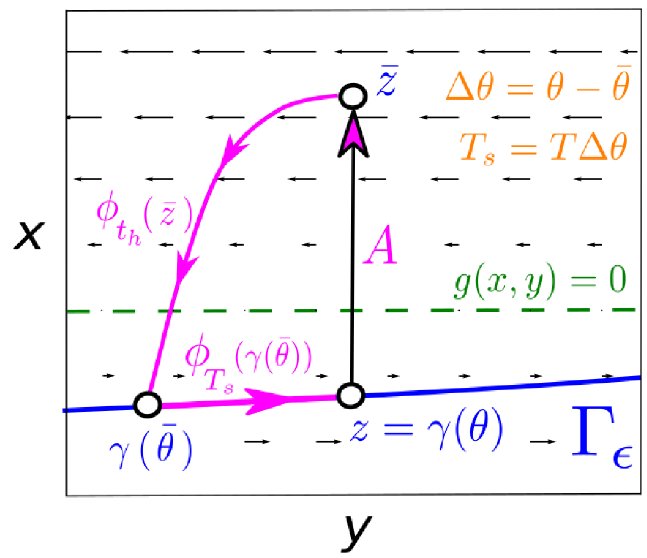
Fig 7. Mechanism preventing the emergence of seizures. To suppress the original oscillation and keep the system in the lower branch of Γ � the amplitude A of the pulse has to be large enough so besides causing a delay Δ θ , it displaces trajectories above enough the slow-nullcline so the distance travelled in the negative direction overcomes the distance travelled in the positive direction, thus causing a negative net displacement. The locking appears by repeating this mechanism after T s = T Δ θ intervals so the new pulse always hits the system at the same initial